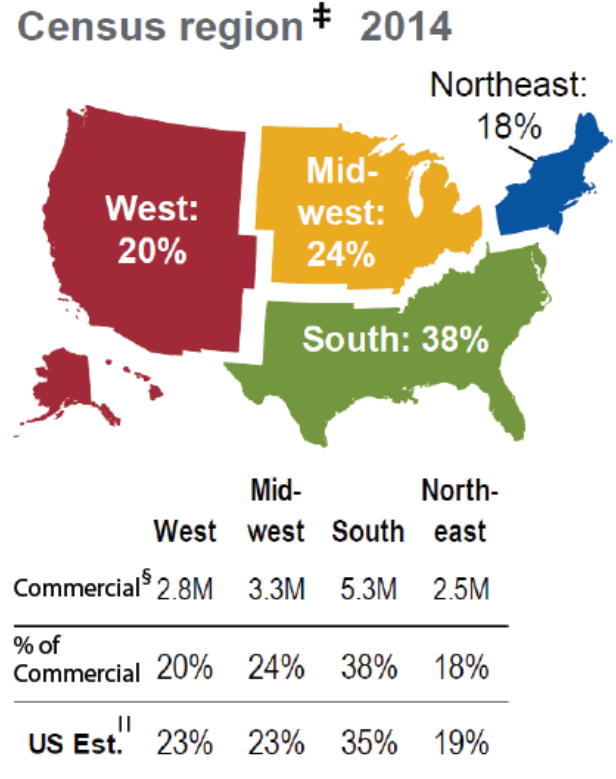
Figure 1. Regional Distribution of Commercial Insurance Claims Data relative to National Data Affiliated Health Plans, Commercially Insured Population with Medical and Pharmacy Benefits